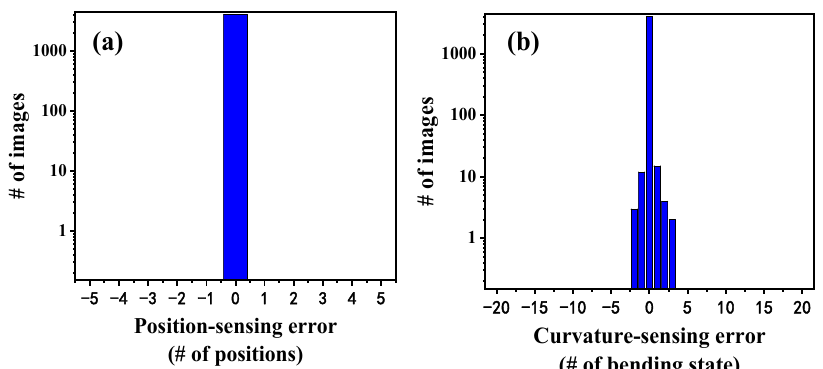
Figure 7. The confusion matrix of the testing set.